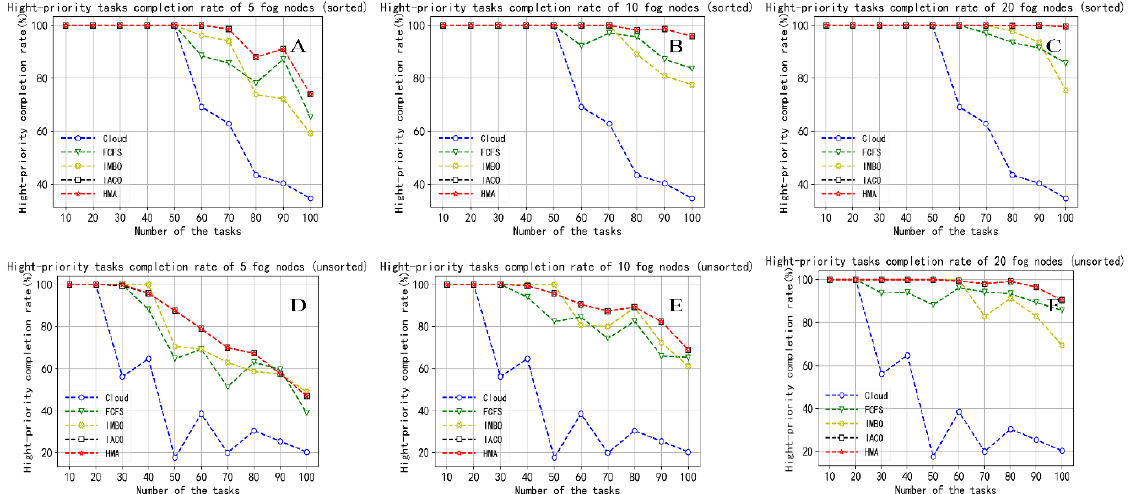
Figure 8. Comparison of the total task completion rate. ( A ) Total tasks completion rate of 5 fog nodes (sorted); ( B ) Total tasks completion rate of 10 fog nodes (sorted); ( C ) Total tasks completion rate of 20 fog nodes (sorted); ( D ) Total tasks completion rate of 5 fog nodes (unsorted); ( E ) Total tasks completion rate of 10 fog nodes (unsorted); ( F ) Total tasks completion rate of 20 fog nodes (unsorted).